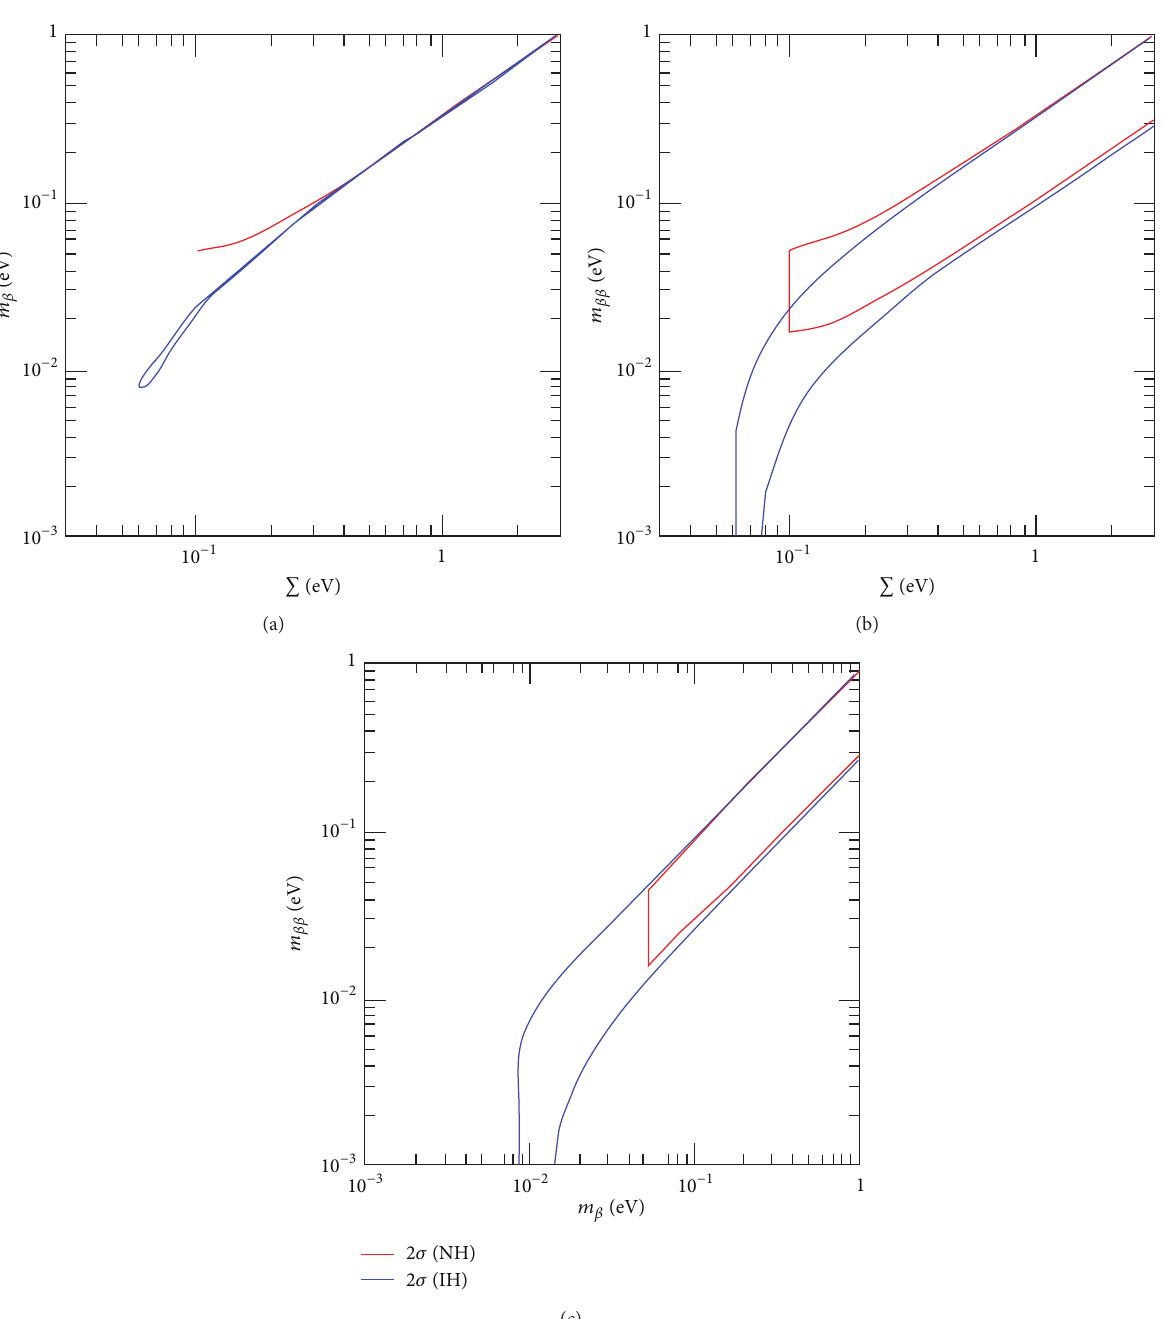
Figure 1: Constraints induced by oscillation data (at 2𝜎 level) in the planes charted by any two among the absolute mass observables. Blue (red) bands refer to normal (inverted) hierarchy. Figure from Fogli et al. [12]. Here |⟨𝑚 ] ⟩| is indicated as 𝑚 𝛽𝛽